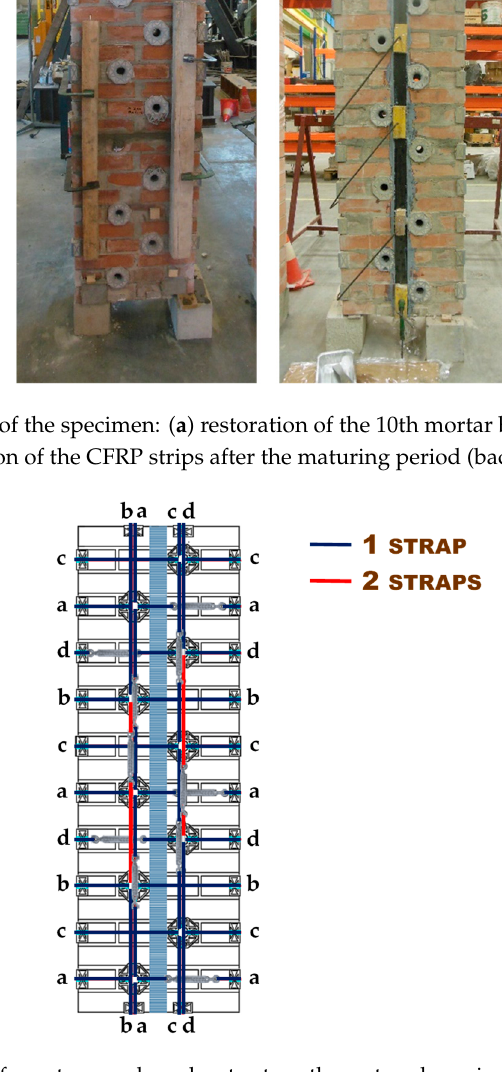
Figure 42. The four staggered meshes to strap the restored specimen (Specimen W5).